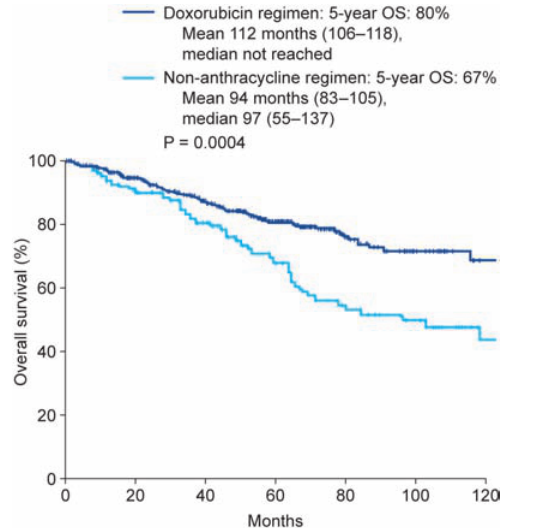
Figure 3. Overall survival (OS) of patients with follic- ular lymphoma who had received chemotherapy regi- mens containing doxoru- bicin and those who had not received this anthracy- cline. 28 Reprinted with per- mission from Rigacci L et al . The role of anthracy- clines in combination che - mo therapy for the treat- ment of follicular lym- phoma: retrospective study of the Intergruppo Italiano Linfomi on 761 cases.